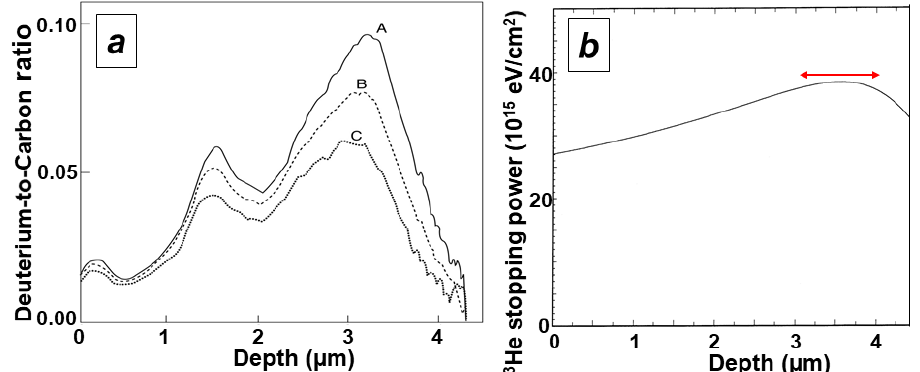
Figure 9. Ion-induced release of D from co-deposits studied with 3 He-NRA: ( a ) the change of D depth profiles with the increased ion dose; “A”, “B” and “C” denote different co-deposit irradiation dose curves; ( b ) 3 He electronic stopping in a carbon target; the red arrow indicates the most effective detrapping